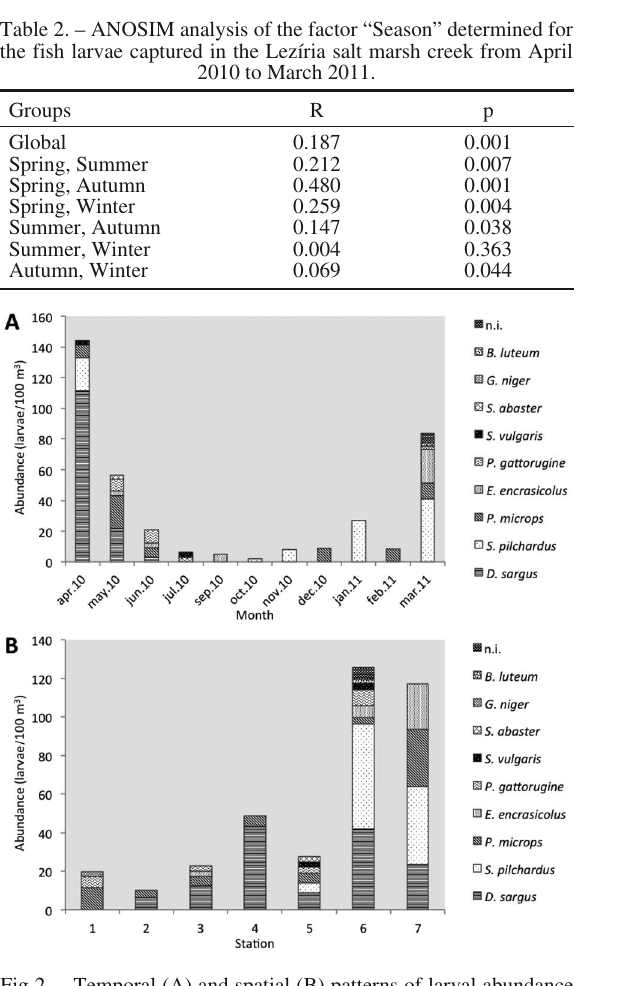
Fig 2. – Temporal (A) and spatial (B) patterns of larval abundance (larvae/100 m 3 ) per species captured in the Lezíria salt marsh creek from April 2010 to March 2011.